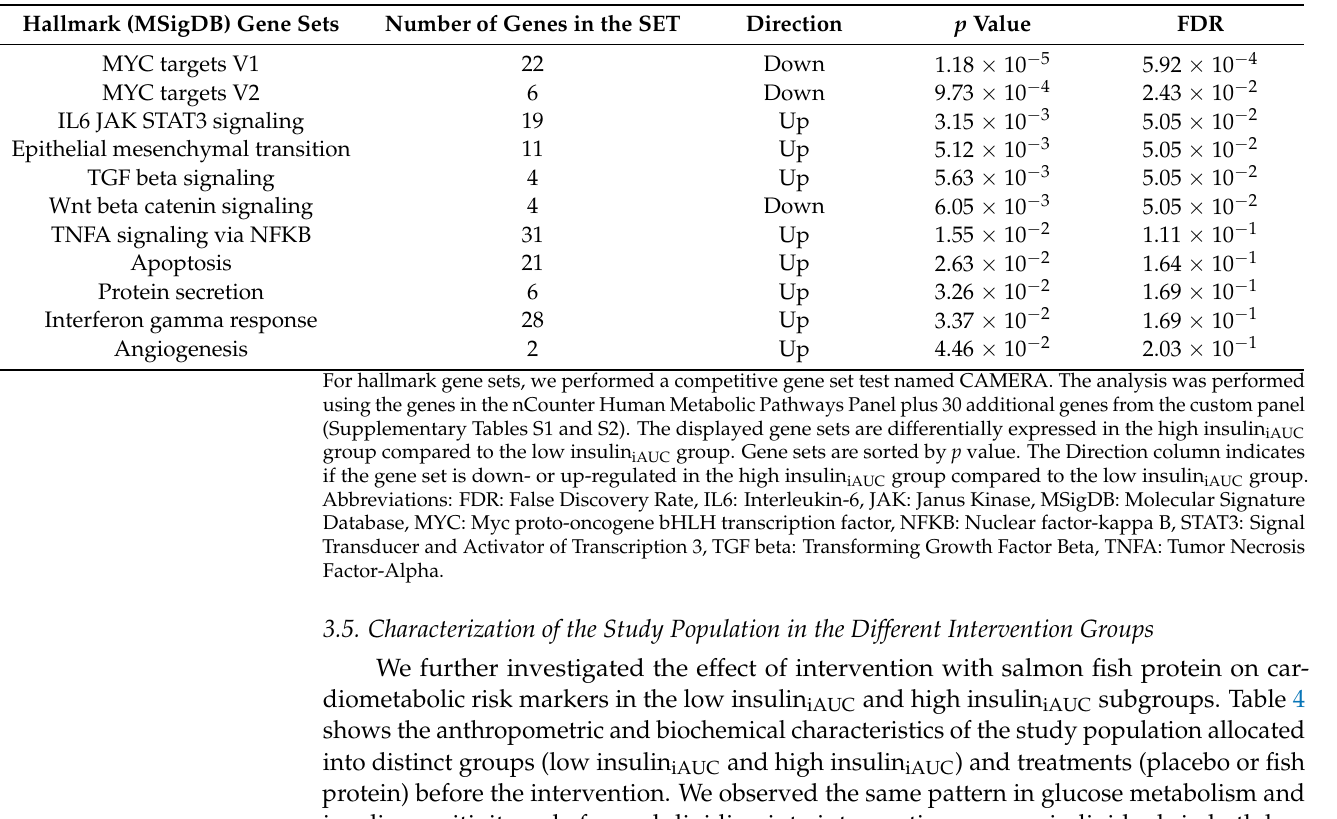
Table 3. Top 10 differentially expressed hallmark gene sets (MSigDB) before